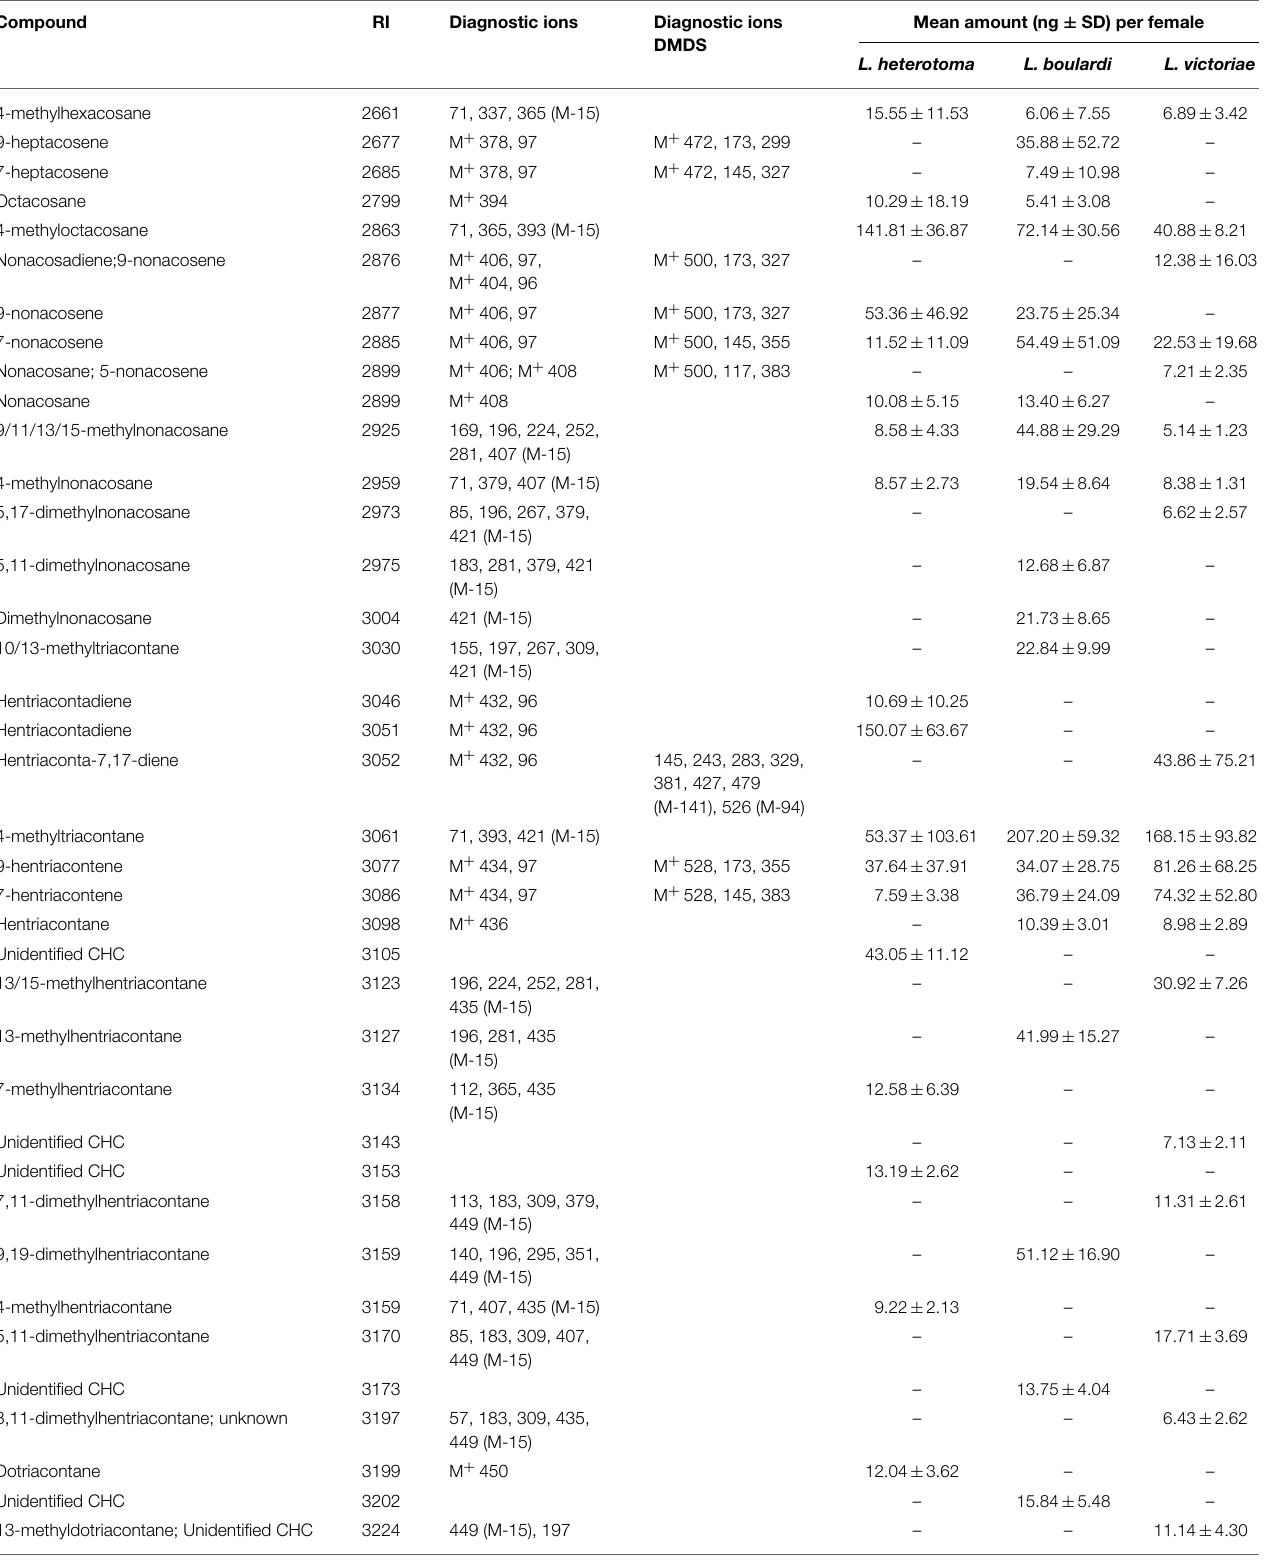
TABLE 3 | Cuticular hydrocarbons and amounts thereof found in females of L. heterotoma , L. boulardi , and L. victoriae .